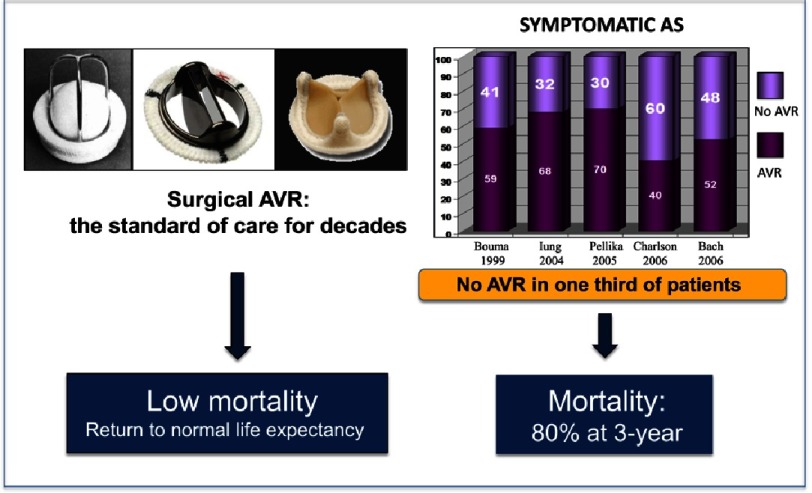
Rational for developing interventional technologies for severe AS: An Unmet Clinical Need.